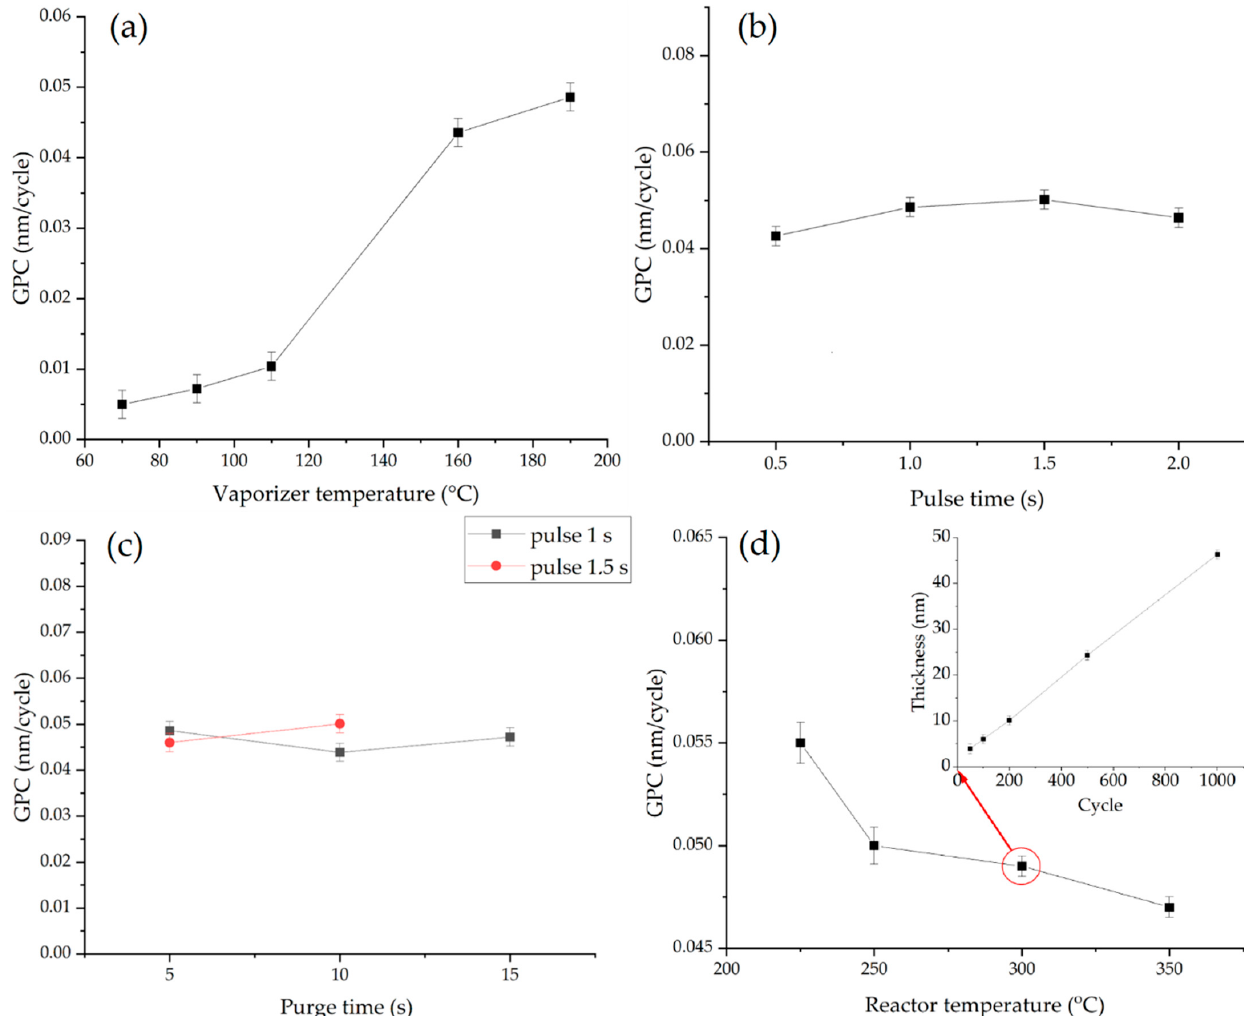
Figure 1. ( a ) The effect of vaporizer temperature (pulse 1 sec, purge 5 sec, reactor 300 °C) on the GPC; ( b ) The GPC as a function of pulse time (purge 5 sec, evaporator 190 °C; reactor 300 °C); ( c ) The influence of reactor purge time for pulses of 1 and 1.5 sec (evaporator 190 °C, reactor 300 °C) on GPC; ( d ) The GPC depending from reactor temperature (pulse 1 sec, purge 5 sec). Inset shows the change in Ta-O film thickness versus number of cycles (pulse 1 sec, purge 5 sec, evaporator and reactor temperature were 190 °C and 300 °C, correspondingly).